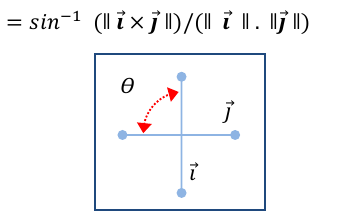
Figure 1. Angular deviation between two lines in 3D Secondly, in the absence of scale differences between two neighbouring scans, the spatial separation between lines and in Figure 2 is invariant to shift and rotation differences. The spatial separation (S) will represent the length of the common perpendicular line between two lines in 3D.